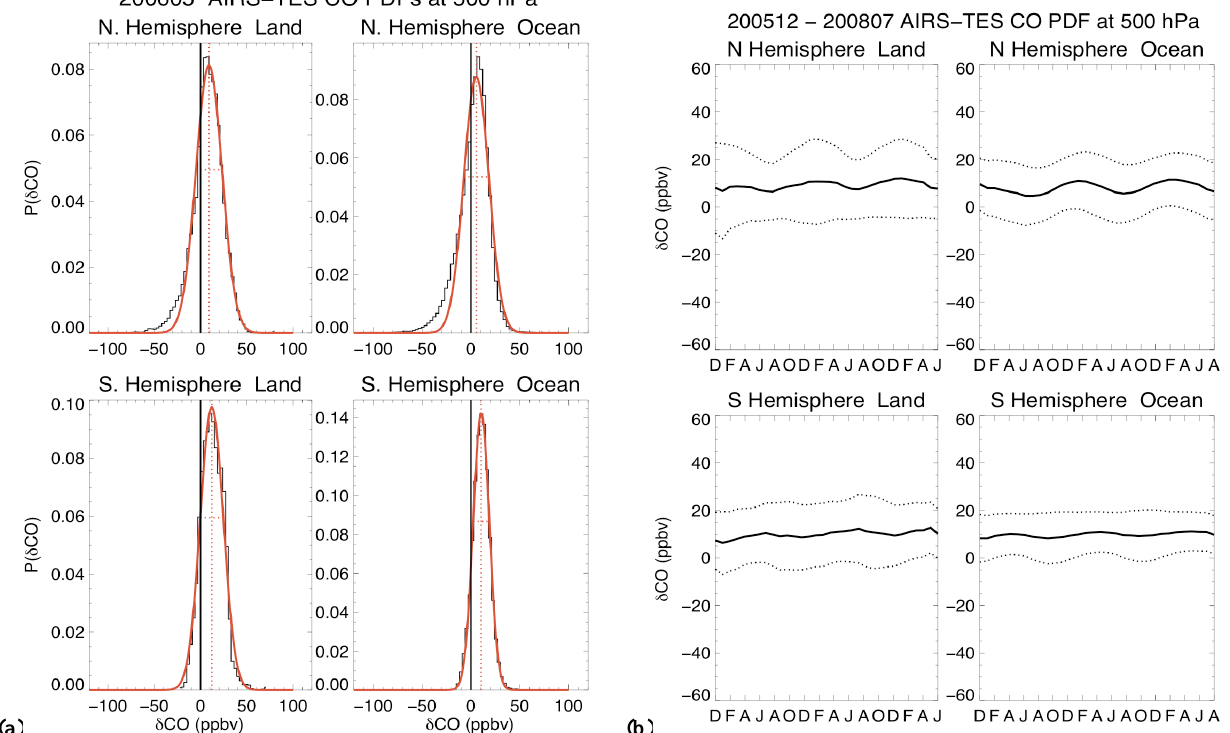
Fig. 1. (a) An example of the CO VMRs (ppbv) difference PDFs at 500hPa between AIRS V5 operational and TES V3 products for May 2006 over the NH land (top left), NH ocean (top right), SH land (bottom left), and SH ocean (bottom right). The PDFs are depicted as the thin black histograms and the red solid curves are the Gaussian function fits to the PDFs for each area. The vertical red dotted lines at the centers of the Gaussian functions are the modes of the function and the horizontal red dotted lines are the FWHMs of the Gaussian fits indicating the SDVs of the dataset. (b) The time series of the biases and the SDVs of the monthly Gaussian fits to the PDFs of the CO VMR differences at 500hPa between AIRS V5 operational and TES V3 products for the period of Dec. 2005 to July 2008 for NH land (top left), NH ocean (top right), SH land (bottom left), and SH ocean (bottom right), respectively. Solid curves show the biases of the Gaussian fits and the dotted curves mark the bounds of the